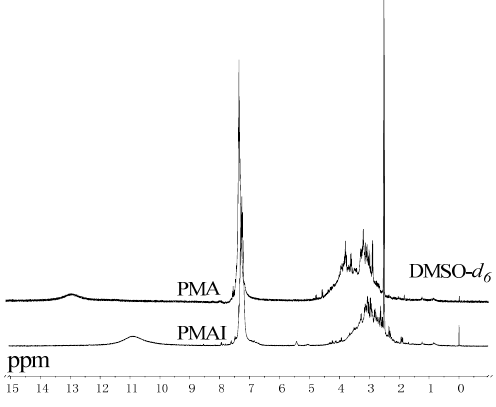
Figure 3. 1 H-NMR spectra of PMA and PMAI.